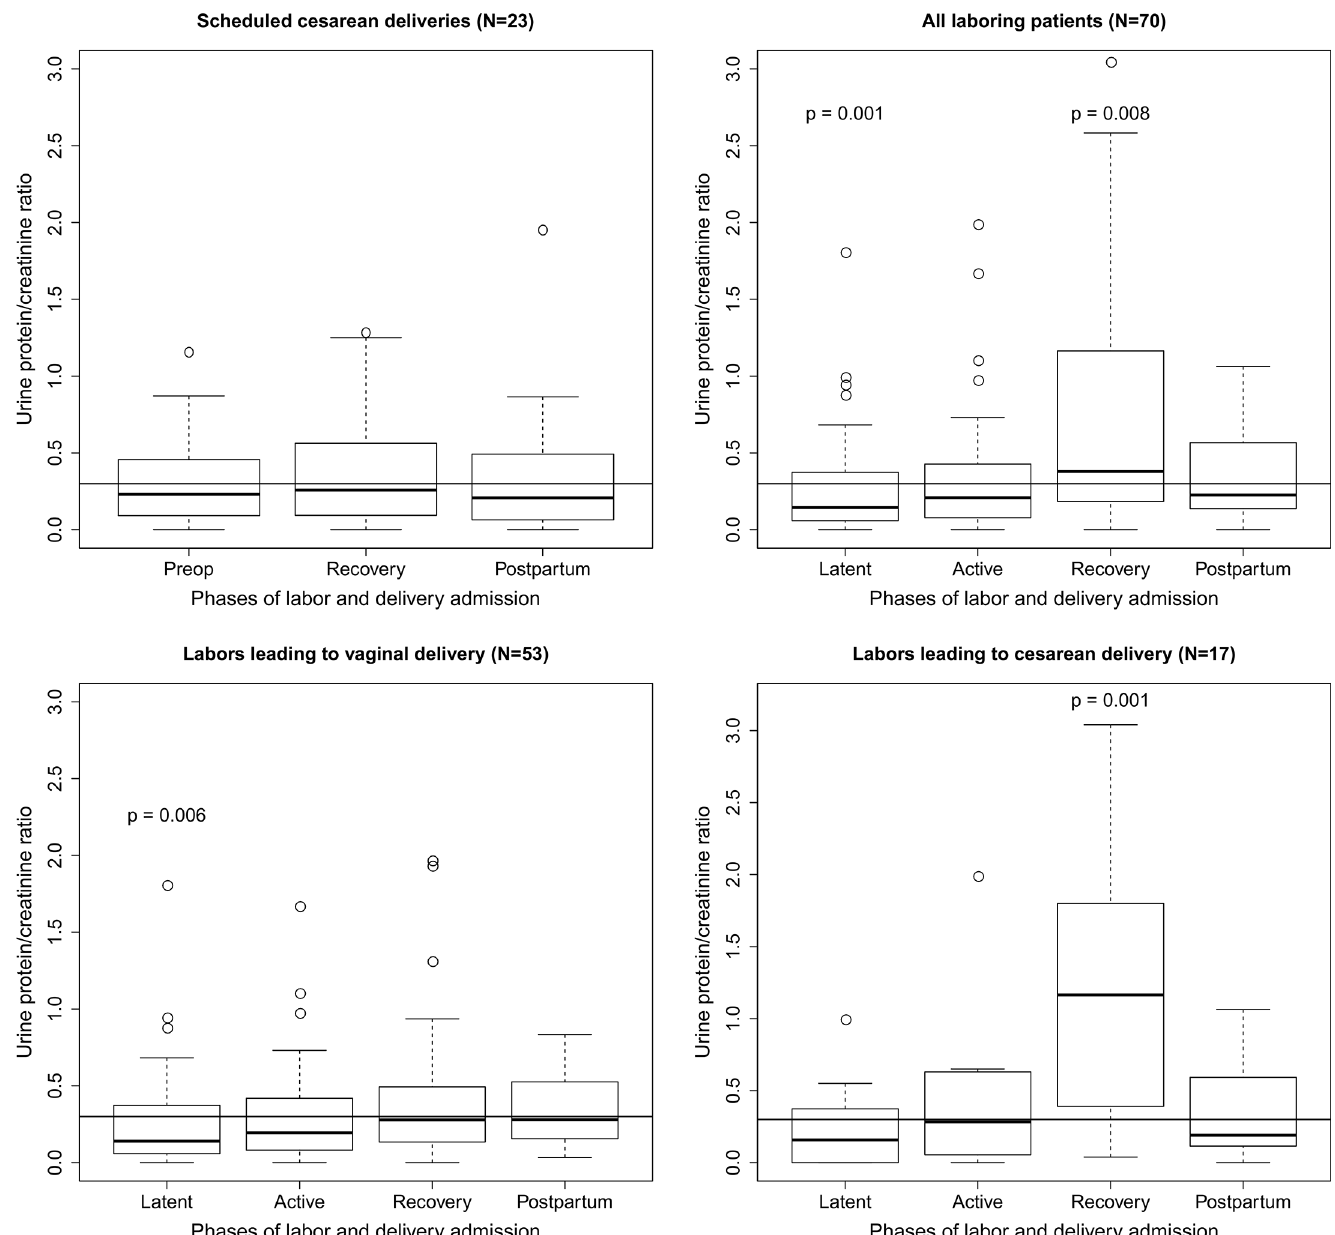
Fig 3. Box plots of urine protein/creatinine ratio (uPCR) measurements by phase of labor at the time of collection and subsequent delivery outcome. uPCR measurements from samples collected before and after delivery among women who had a scheduled cesarean delivery without labor ( top left ), all laboring women ( top right ), laboring women who delivered vaginally ( bottom left ), and laboring women who subsequently delivered by cesarean ( bottom right ) are shown. The horizontal line on each graph represents the threshold uPCR value of 0.3. When the distribution of observed uPCR values is significantly different than the threshold value of 0.3, the p-value (Mann-Whitney u test) is shown.